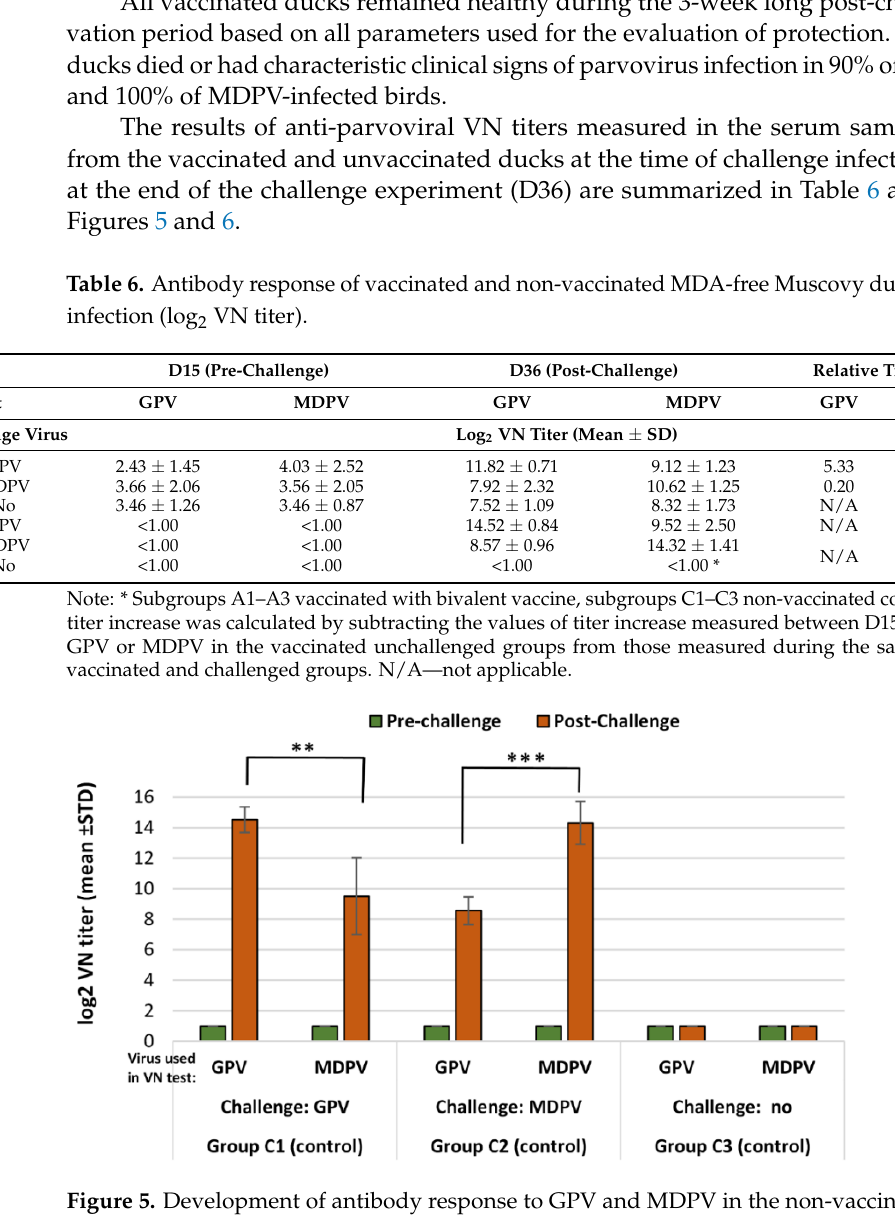
Figure 5. Development of antibody response to GPV and MDPV in the non-vaccinated MDA-free ducks, following challenge infection with GPV or MDPV at 2 weeks of age. Statistical comparison of post-challenge virus neutralization titers against GPV and MDPV indicate that significantly higher VN titers against homologous virus than against the heterologous one (in case of GPV infection ** p = 0.0022; in case of MDPV infection *** p = 0.0005). No zero-conversion was found in non-challenged